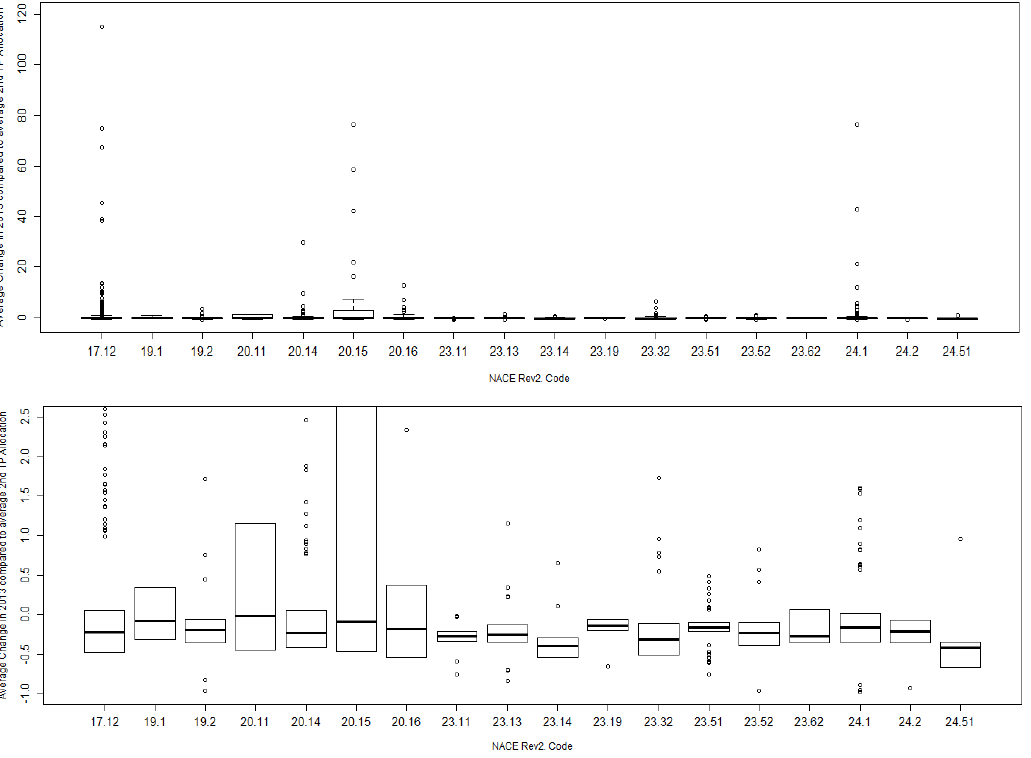
Figure 2. Spread of the Average Allocation Change in 2013 compared to the average of the 2nd Trading Period by NACE Code with different scaling of the vertical axis. Note: Top figure truncated at 120 which means three outliers from the paper sector are not displayed. Bottom figure truncated at 2.5. Dark lines indicate the median, the boxes mark the range containing 50%, with half below the dark line and half above. The bars below and above indicate the 1st (lowest) and 4th quantiles. Dots indicate outliers that are defined as beyond +/−1.5 inter-quantile range from the ends of the thin bars.